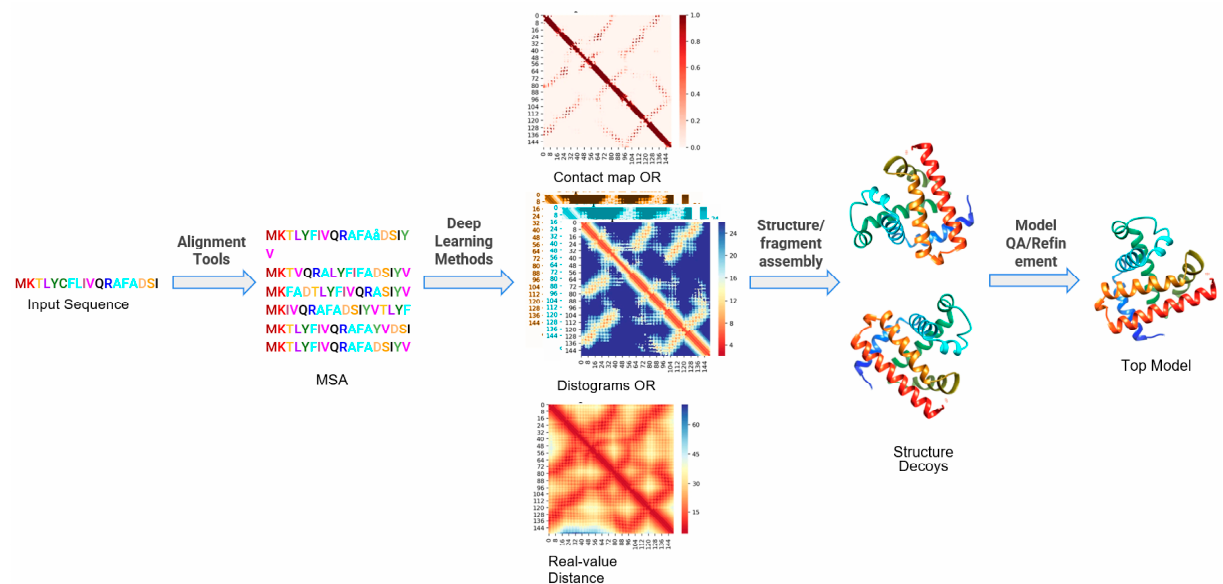
Figure 1. General schematic of template-free protein structure prediction pipeline. Most of the successful existing pipelines for protein structure prediction have these important steps: (i) generation of multiple sequence alignment (MSA), (ii) contact map prediction, distogram prediction or real-value distance prediction, (iii) structure/fragment assembly, and (iv)